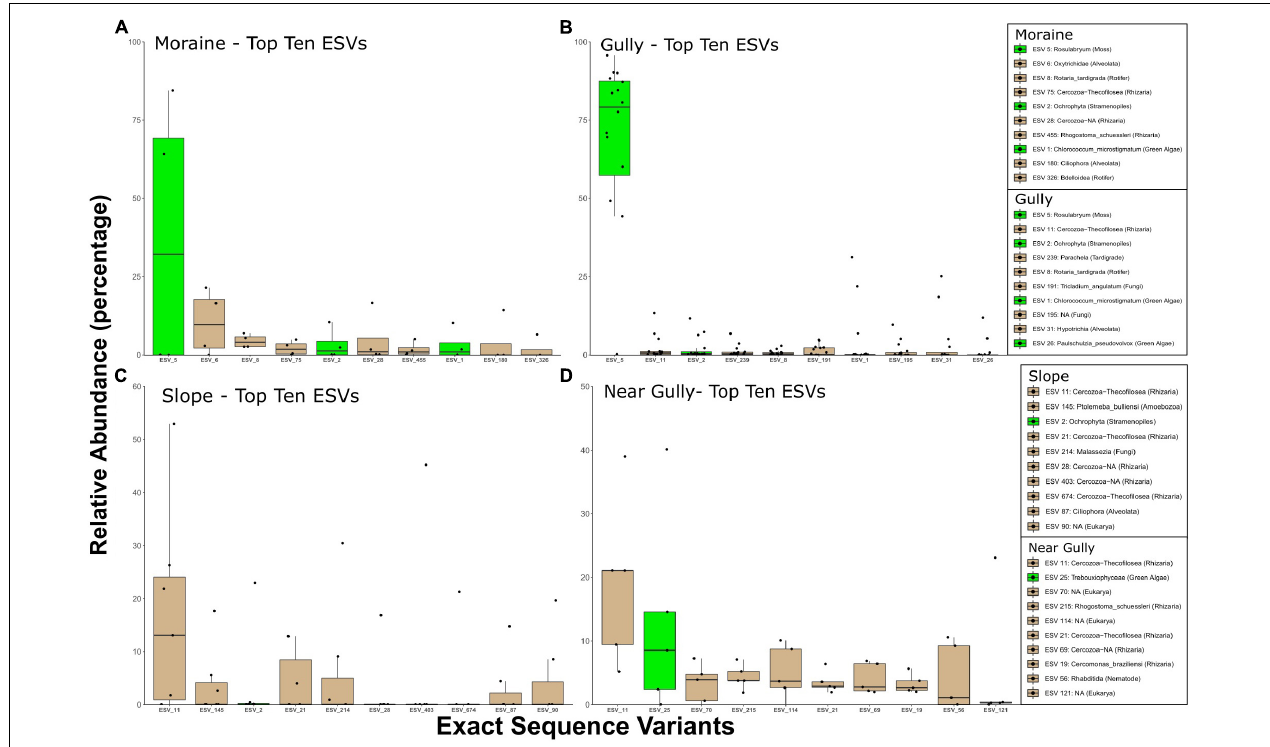
FIGURE 7 | Top 10 18S ESVs from each habitat (A) moraine, (B) gully, (C) slope, and (D) near gully. Boxplots are ordered by the median relative abundance of untransformed DNA-seq data and colored according to inferred energy-carbon acquisition- photoautotrophs (green) and chemoheterotrophs (tan).